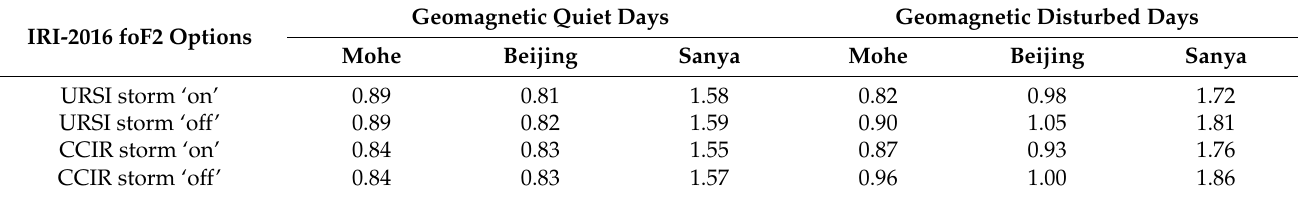
Table 2. RMS values of four IRI-2016 foF2 options during geomagnetic disturbed/quiet days in the years 2014 and 2016 (unit: